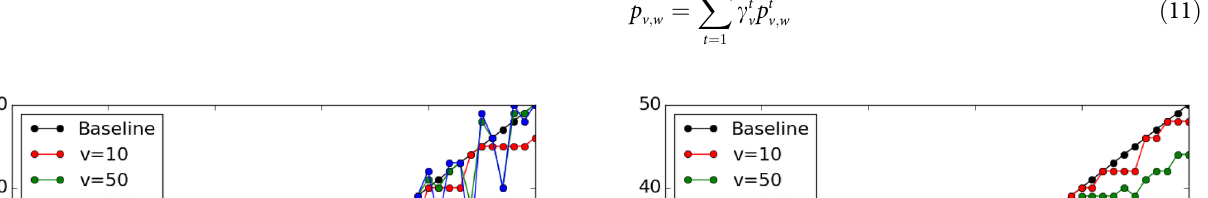
Fig 3. The topic entropy. (a) Comparison between PageRank, LeaderRank and TD-Rank; (b) Comparison between TD-Rank and TwitterRank on top 10 users.